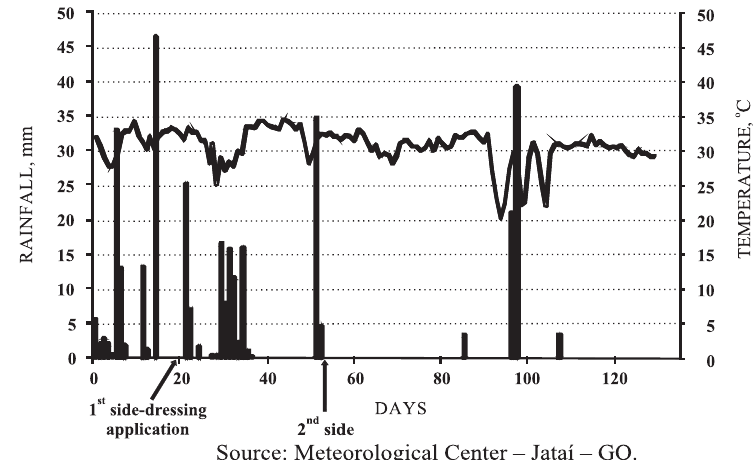
Figure 1. Temperature and rainfall during the experimental